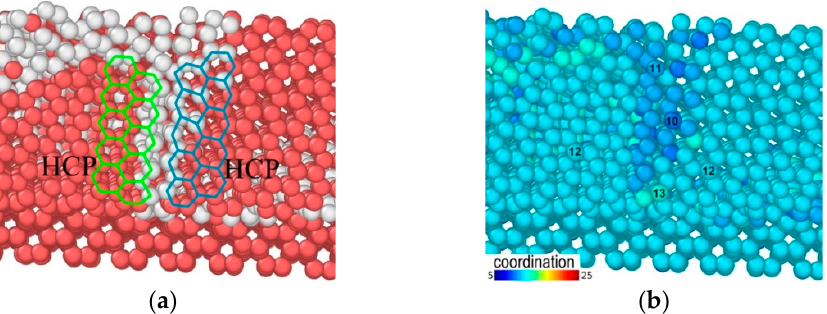
Figure 9. The spatial arrangement of atoms ( a ) and their coordination numbers ( b ) in the defect region of the titanium crystallite after three penetrations of the indenter.